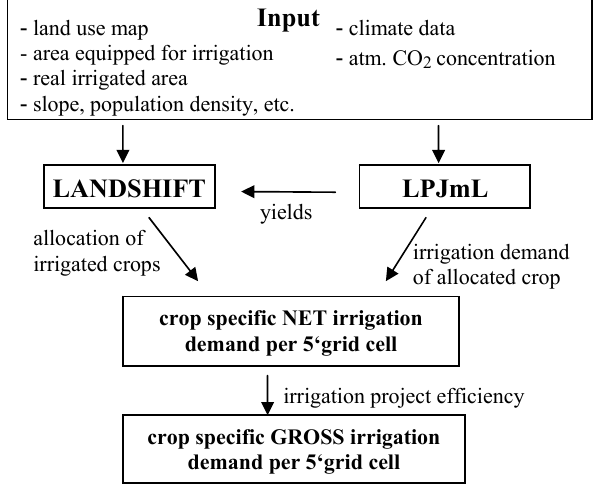
Figure 1: Model framework concept LPJmL/LandSHIFT Fig. 1. Model framework concept